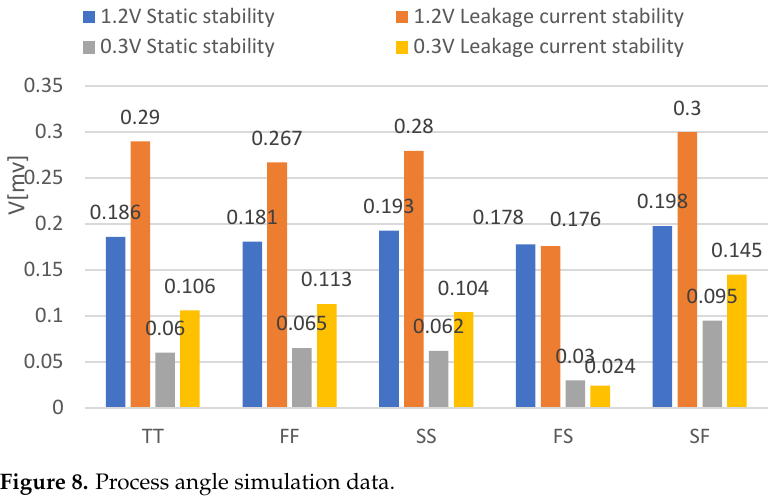
Figure 8. Process angle simulation data.